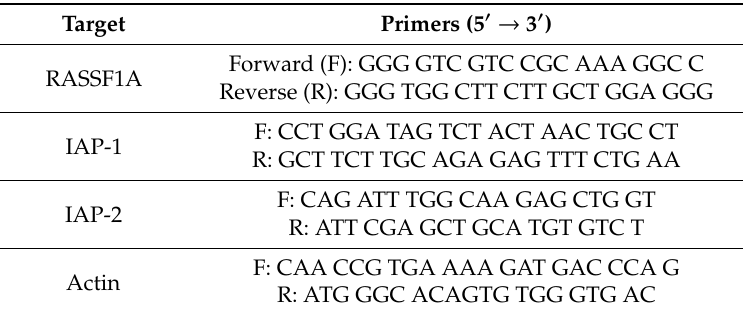
Table 2. Primers used for RT-PCR in this